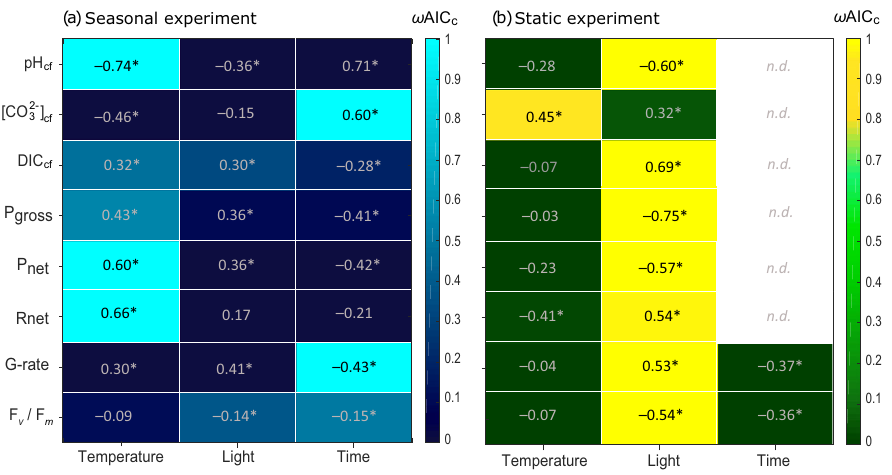
Fig. 2 Pearson correlation coef fi cients and importance scores. Matrix of Pearson Correlation Coef fi cients and Importance Scores based on Akaike weights corrected for sample size ( ω AICc) from linear mixed model analyses for ( a ) the seasonal experiment and ( b ) the static experiment exploring the in fl uence of temperature, light, and time on the pH of the calcifying fl uid (pH cf ), carbonate ion concentration in the calcifying fl uid ([CO 3 2- ] cf ), dissolved inorganic carbon in the calcifying fl uid (DIC cf ), gross photosynthesis rate (P gross ), net photosynthesis rate (P net ), net dark respiration rate (R net ), calci fi cation rate (G-rate), and photochemical ef fi ciency (F v /F m ). For ω AICc, a value of 1 is highly important while 0 is least important. Asterisks denote signi fi cant models and n.d. indicates where temporal data (>1 time point) were not available to test time as a